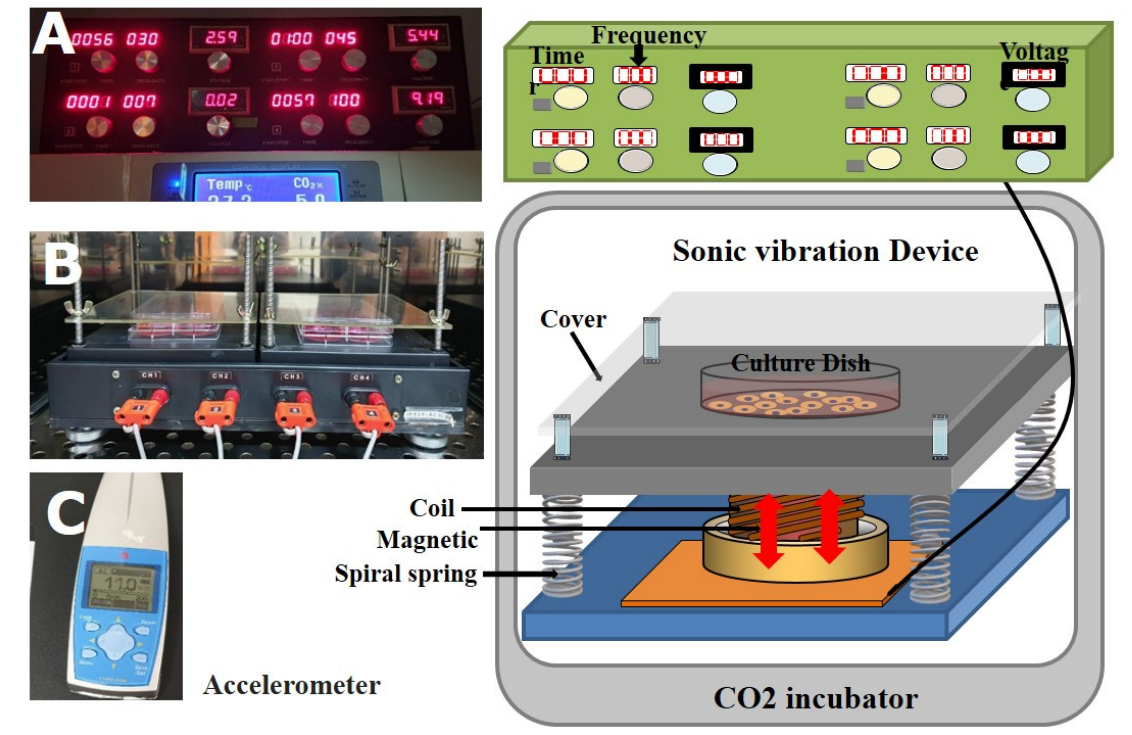
Figure 7. The schematic diagram of the mechanical vibration culture and photographs of the controller ( A ) and vibrator ( B ). The controller regulates the intensity, frequency, and operation times ( C ). The four channels of the vibrator were made using the principles of speakers.